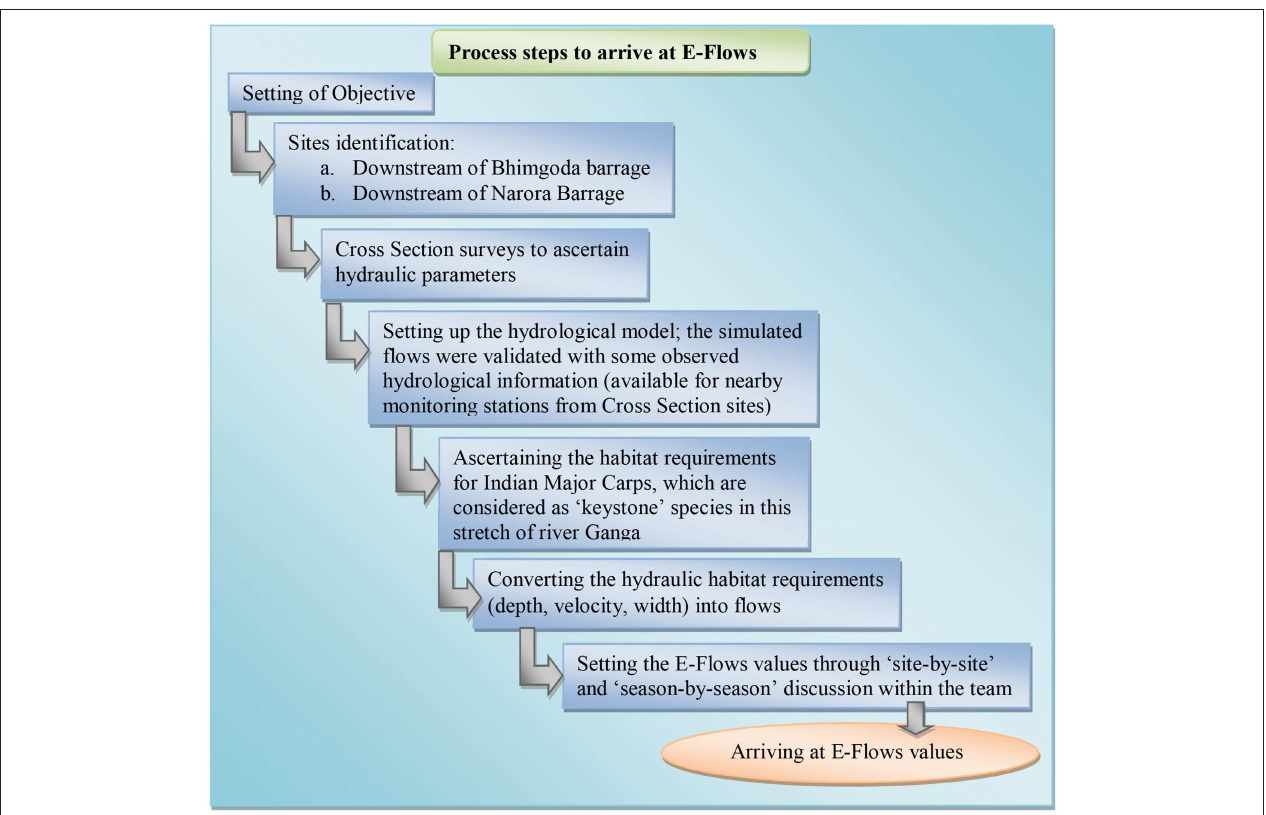
FIGURE 4 | Flow chart to illustrate the process to arrive at E-Flows recommendations (Source: WWF India and IIT Kanpur).